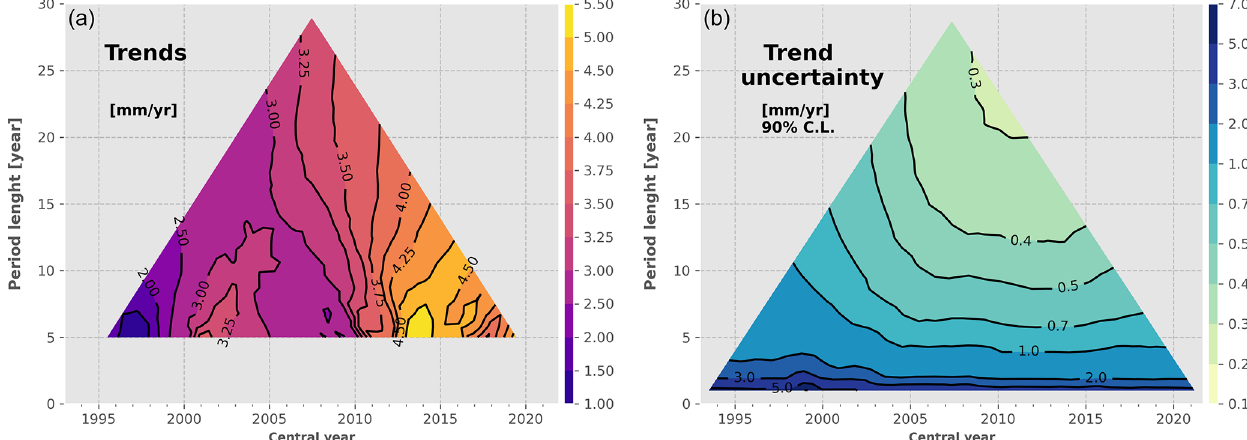
Figure 6. GMSL trends (a) and trend uncertainties (b) of the L2P21 product estimated for all period lengths between 5 years and the total altimetry record (January 1993 to October 2021). Only the significant values (i.e. above uncertainties) are shown. The x axis corresponds to the central year of the considered period ( y axis). The uncertainties are shown at the 90% confidence level.